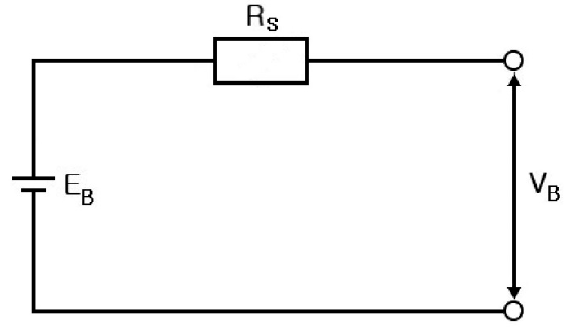
Figure 1. Simple battery model [1].